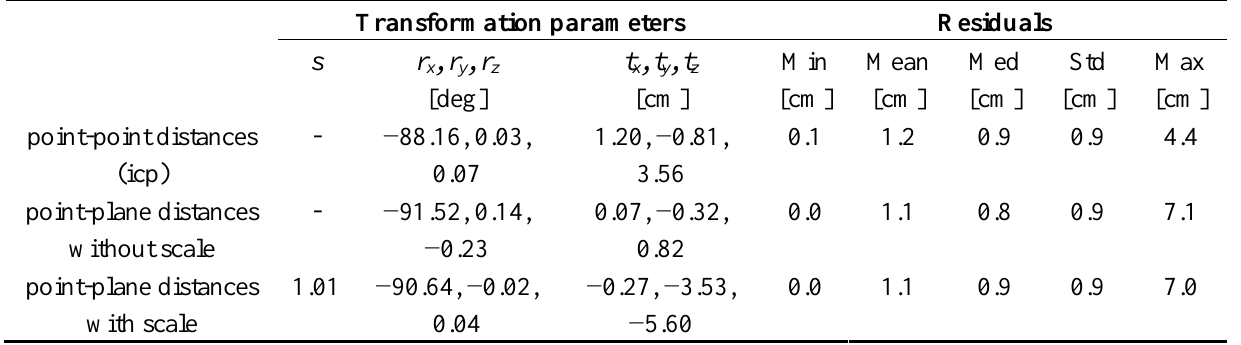
Table 3. Registration results of the three